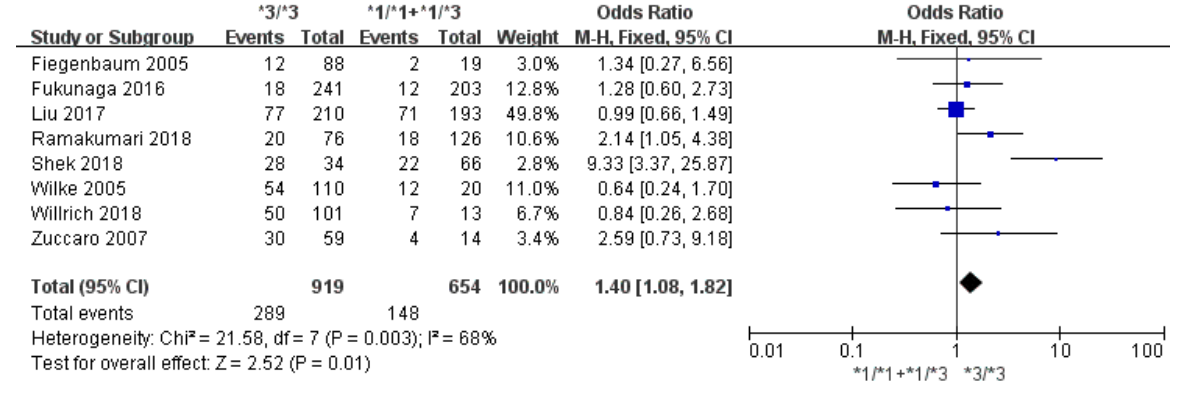
Figure 2. Forest plots of the association between CYP3A5*3 and statin adverse events.